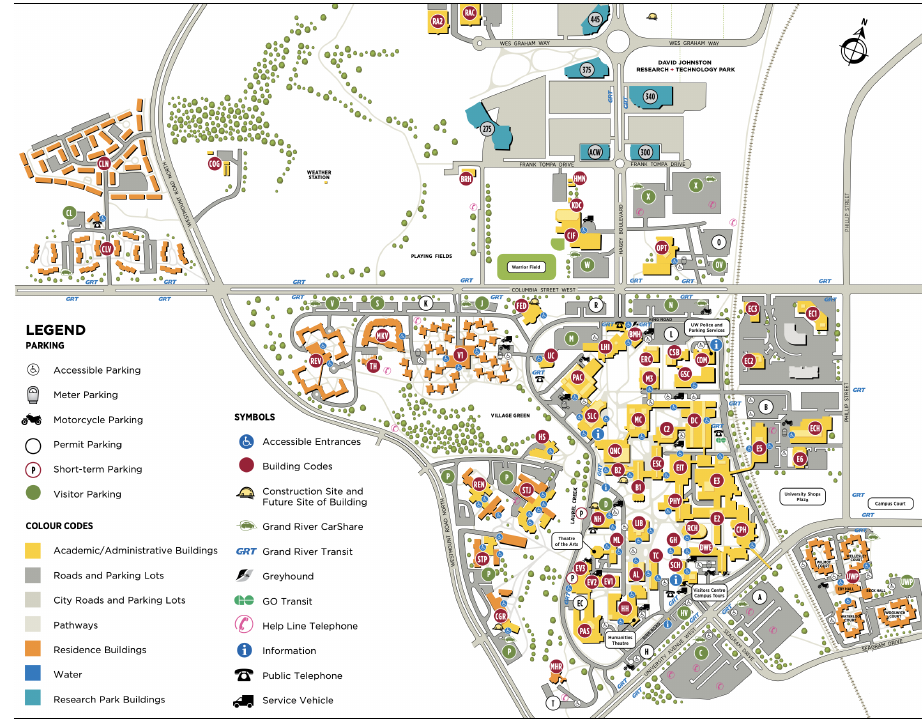
Figure 2. University of Waterloo—campus map (Source: